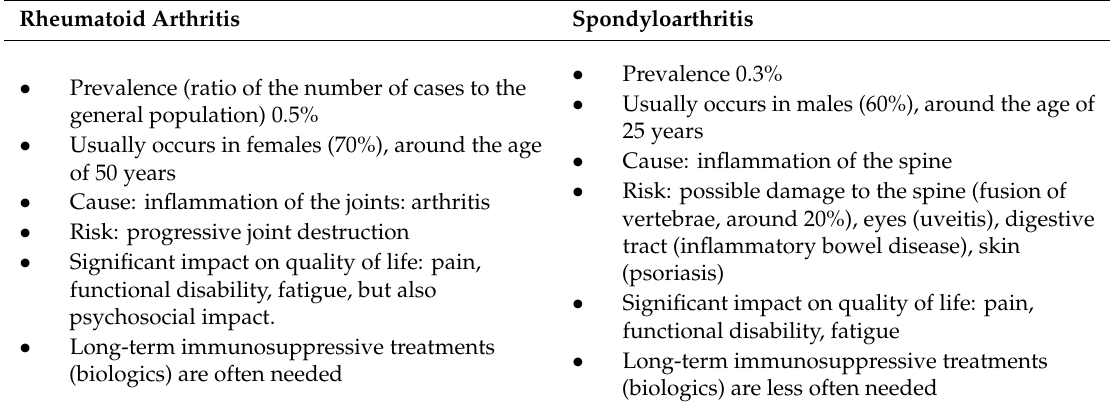
Table 1. Overview of rheumatoid arthritis and axial